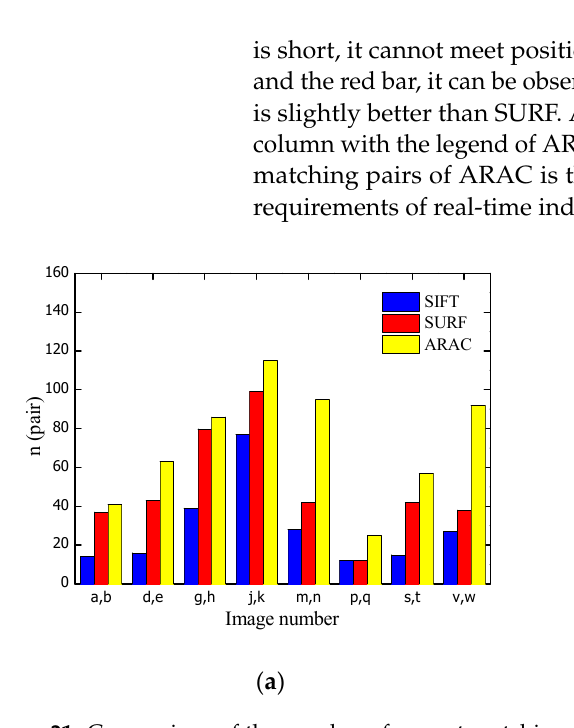
Figure 21. Comparison of the number of correct matching pairs denoted by “n” on the vertical axis: ( a ) data under the condition of illumination change and affine transformation; ( b ) data under the condition of illumination change and large-angle affine transformation.